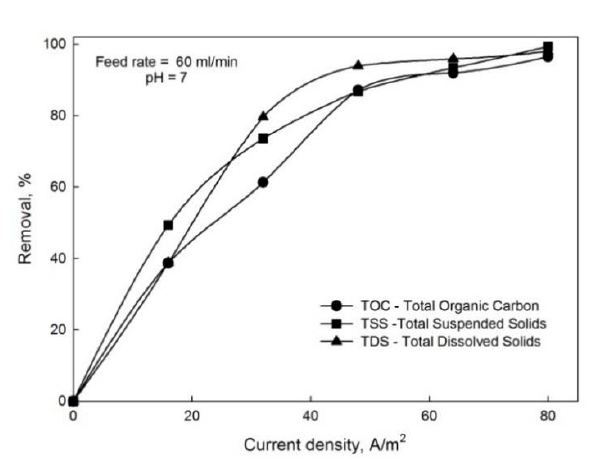
Figure 9. Effect of current density on removal